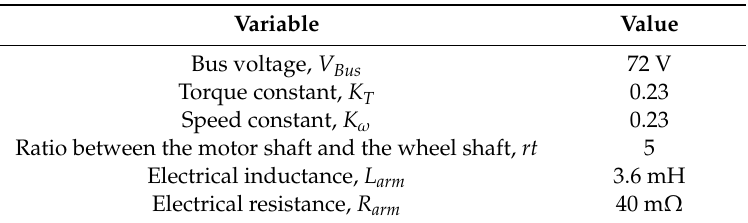
Table 1. Motor-vehicle compensators data.